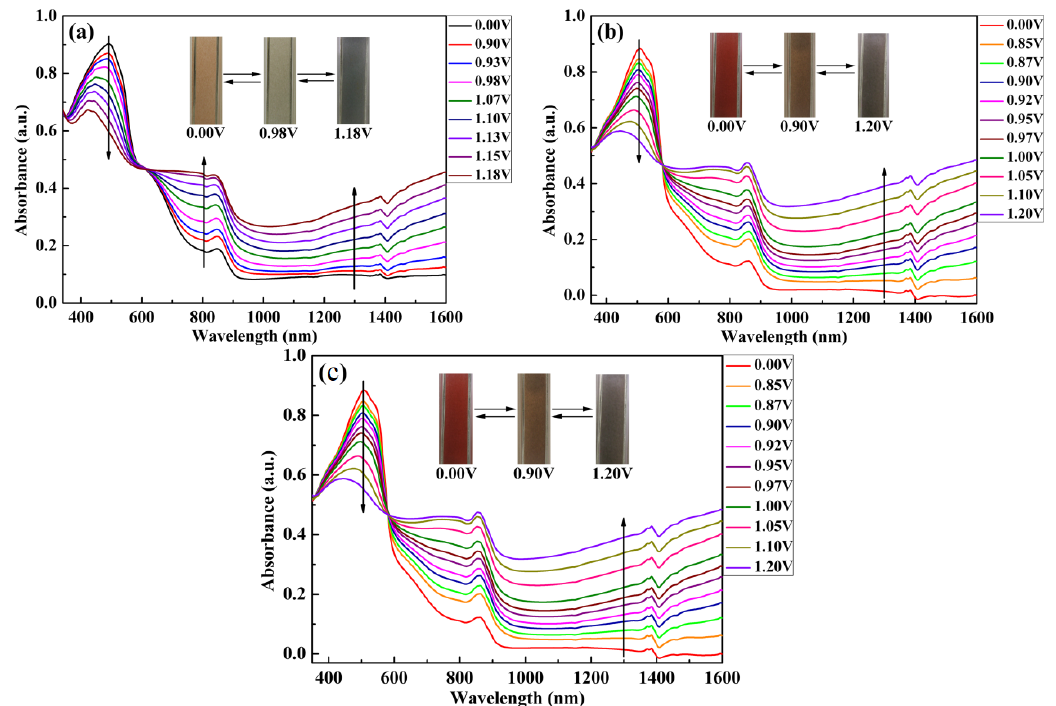
Figure 6. Spectroelectrochemical spectra of PBPE-1 ( a ), PBPE-2 ( b ), PBPE-3 ( c ) and corresponding color changes under different voltages.